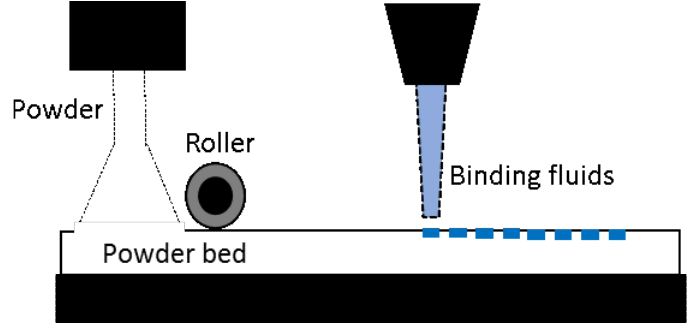
Figure 2. Zipdose ® Technology developed by Aprecia Pharmaceuticals.